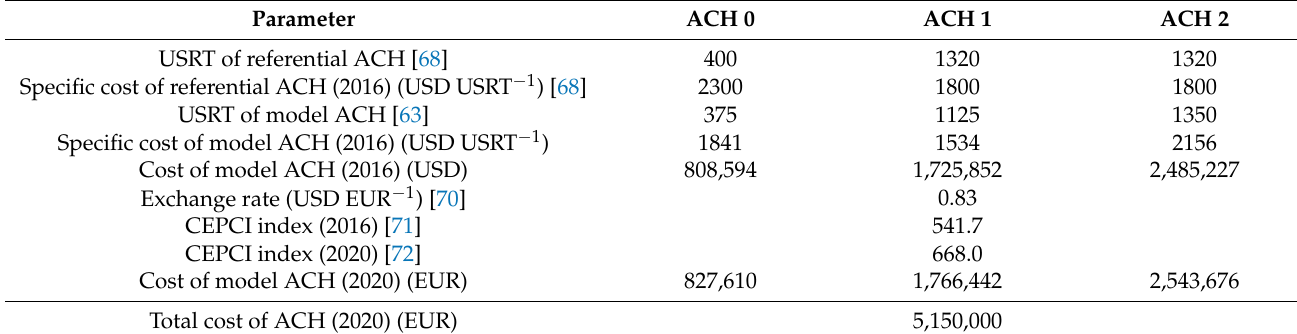
Table 1. Estimation of ACH investment costs. ACH: absorption cooler, CEPCI: Chemical Engineering Plant Cost Index, USRT: U. S. Refrigeration Ton.